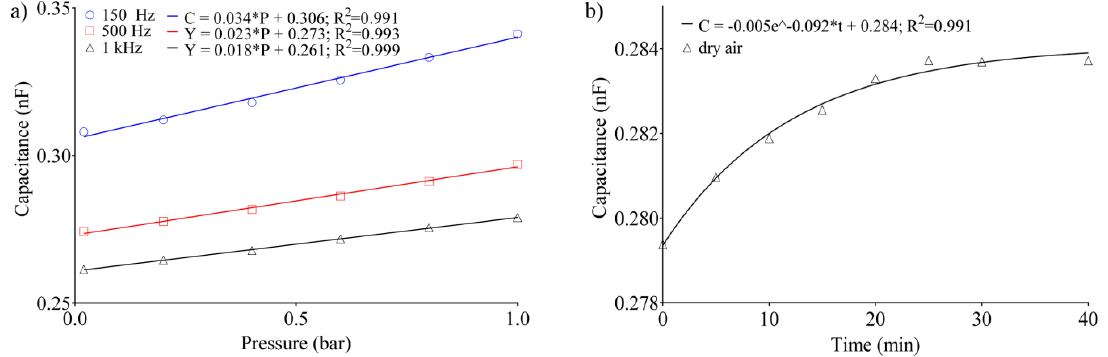
Figure 7. ( a ) Electric capacitance vs. pressure at three different frequencies onto the same sample. ( b ) Time evolution of the capacitance at constant pressure and temperature.